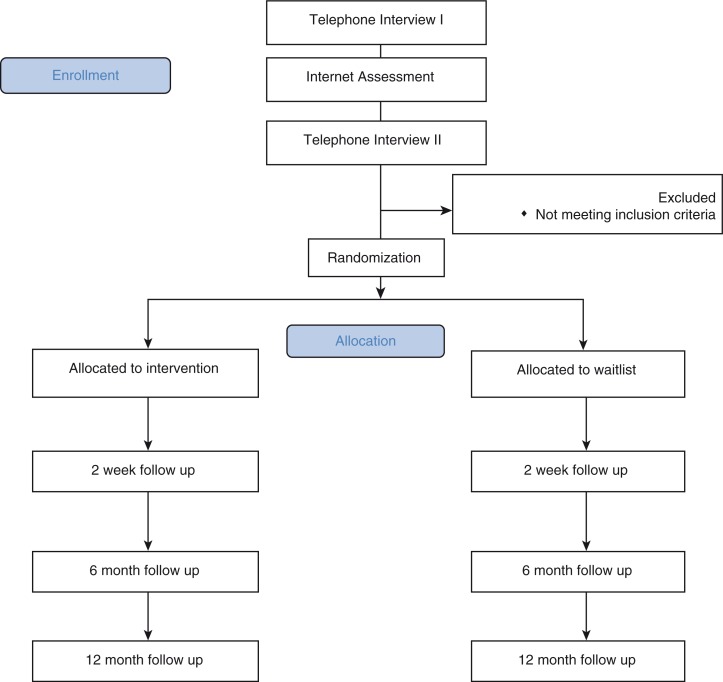
CONSORT diagram.